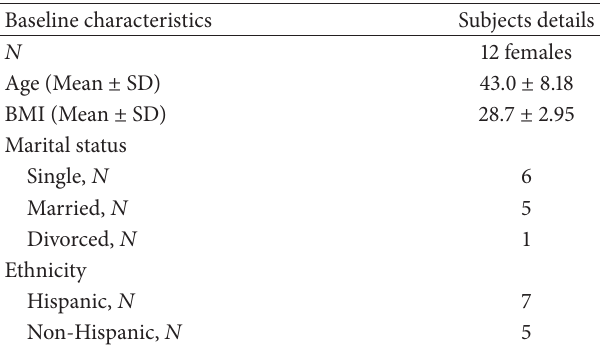
Table 1: Baseline characteristics of the